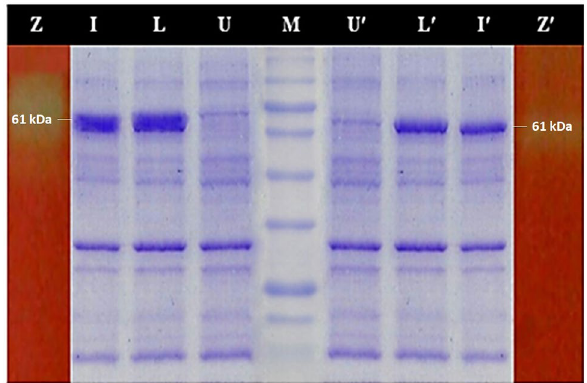
Figure 2. SDS-PAGE expression analysis for recombinant cellulase. M: Protein marker (BioLabs-P7706L), Lane U, U ′ : Un-induced samples, Lane I, I ′ : Samples with IPTG induction, Lane L, L ′ : Lactose induction, Lane Z, Z ′ : Zymogram of recombinant cellulase against CMC; in modified M9NG and LB media respectively.